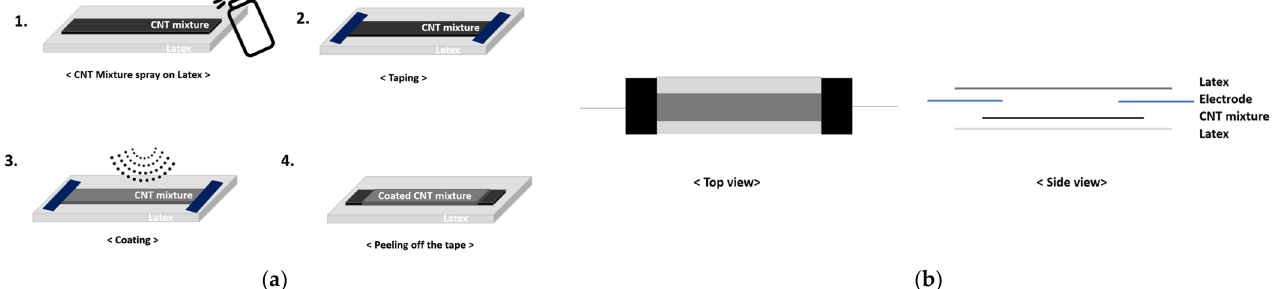
Figure 4. Encapsulation production process: ( a ) ( 1 ) CNT Mixture spray on latex. ( 2 ) Taping. ( 3 ) Latex spray coating. ( 4 ) Tape removal. ( b ) Erection measurement sensor structure diagram top and side views.